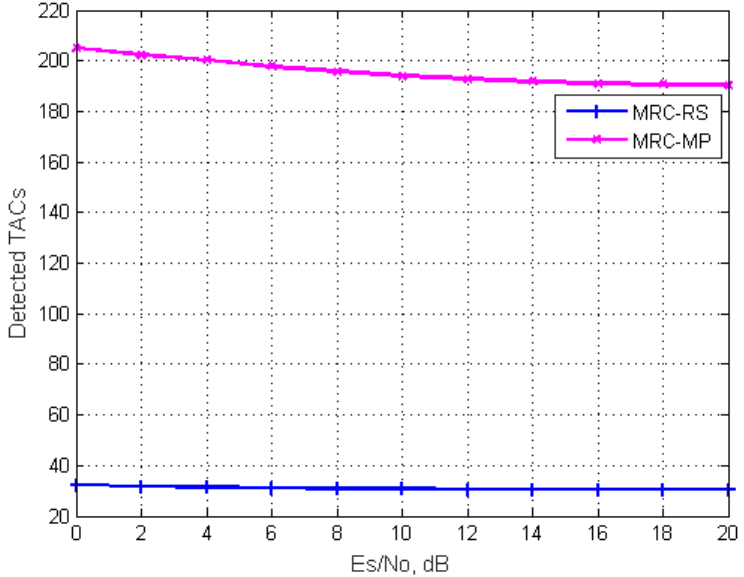
Figure 4. Average number of TACs detected by MRC-RS and MRC-MP algorithms for a GSM system with N t = 32, N r = 16, M = 8 and N p = 2.